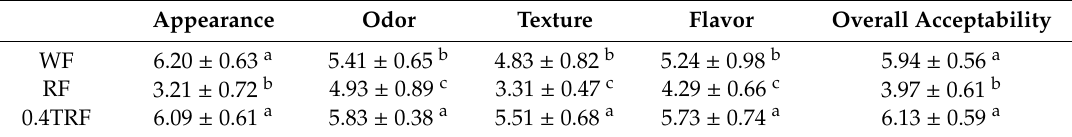
Table 5. Sensory evaluation of